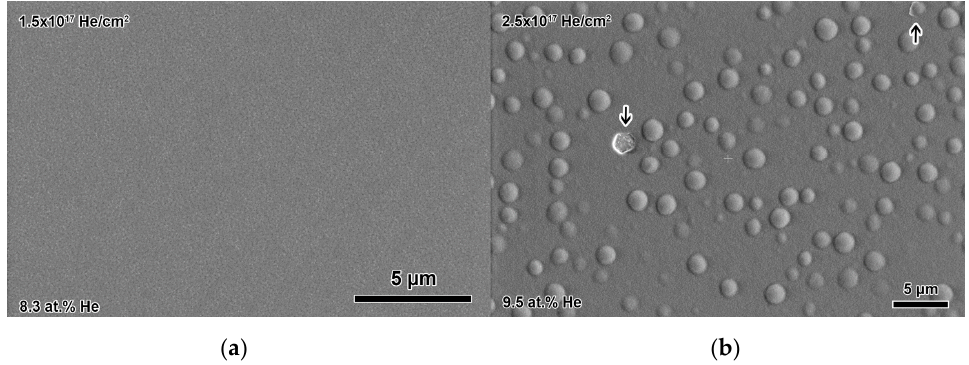
Figure 4. Secondary electron SEM images of bulk implanted multilayers, showing ( a ) the unchanged surface microstructure present up to a fluence of 1.5 × 10 17 He/cm 2 and ( b ) blisters on the surface after a fluence of 2.5 × 10 17 He/cm 2 .